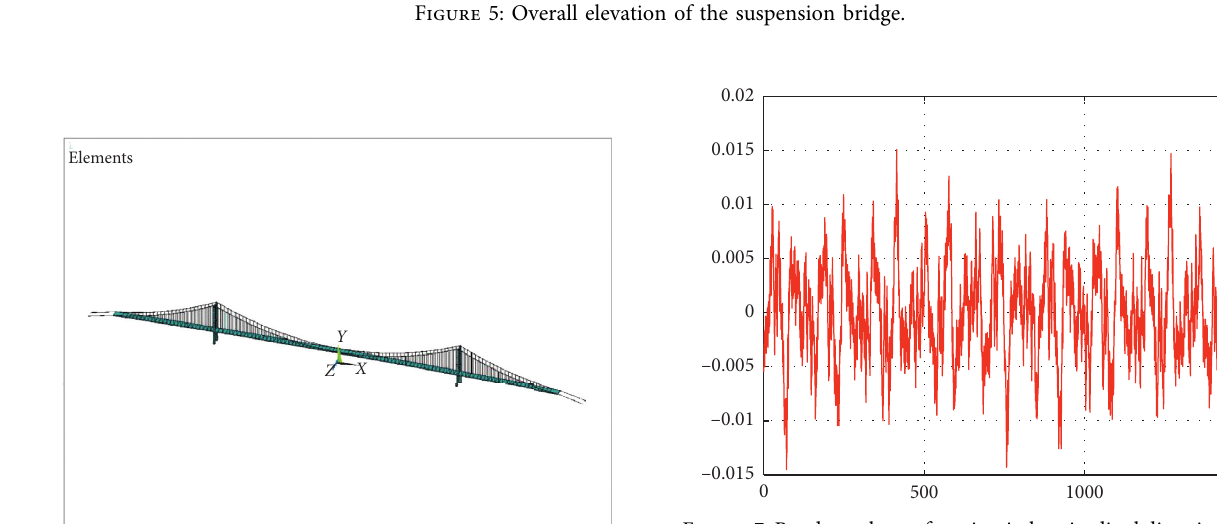
Figure 7: Road roughness function in longitudinal direction of the stiffened girder (showing the road roughness and the road roughness derivative of half span length only, the other half is taken